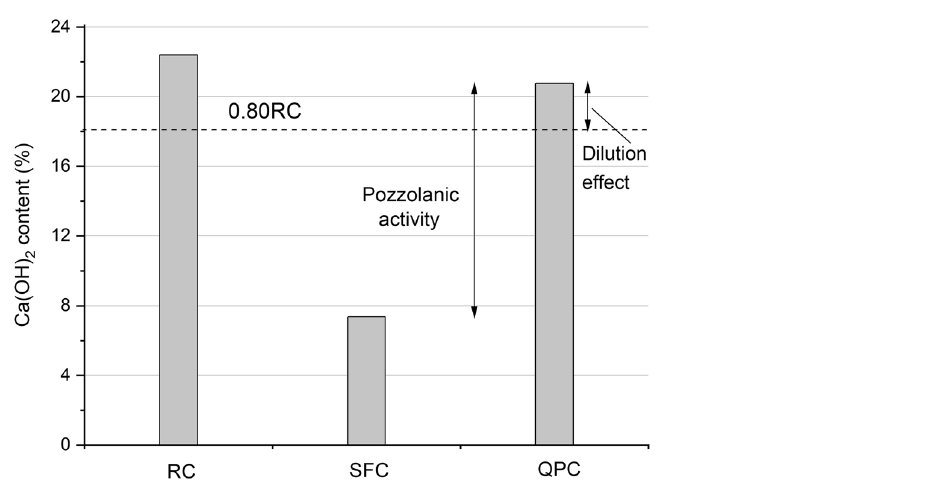
Figure 6. Ca(OH) 2 contents of the RC, SFC and